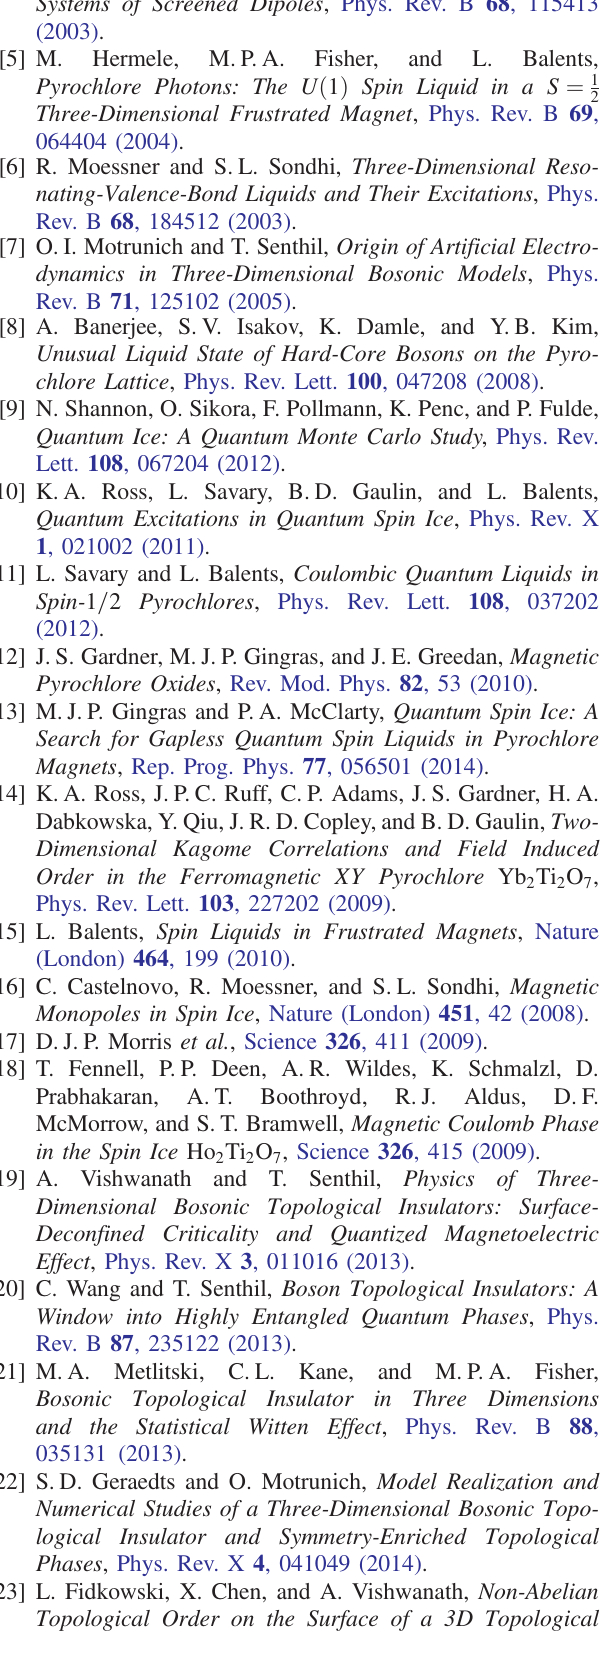
M M , E and other bT b fT b